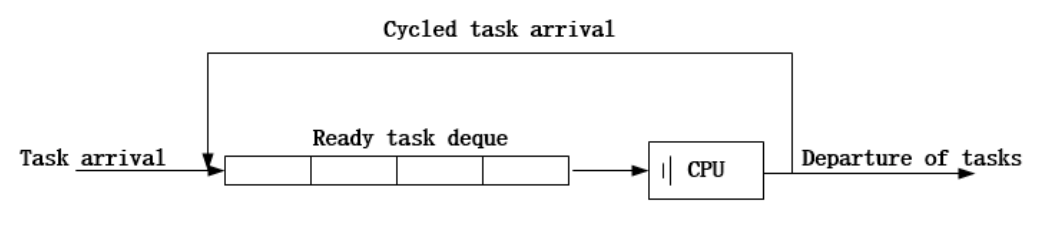
Figure 5. Time-sharing system model.